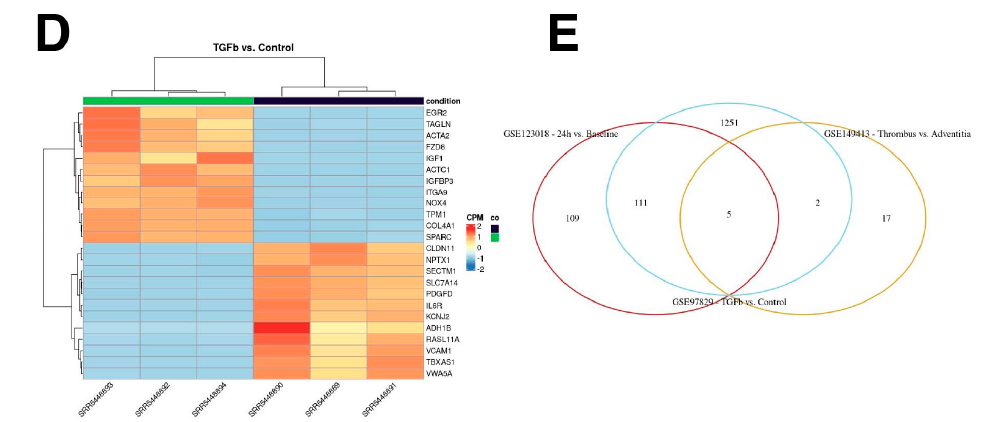
Figure 7. The FibroDB web application. ( A ) The frontpage of FibroDB. ( B ) An example of expression profile of LINC00622 . The normalized values can be changed from the pull-down menu to select CPM, RPKM, or TPM values. ( C ) An example of volcano plot for the study condition selected. ( D ) An example of heatmap of differentially expressed genes. ( E ) An example of Venn diagram for up-regulated genes among studies registered in